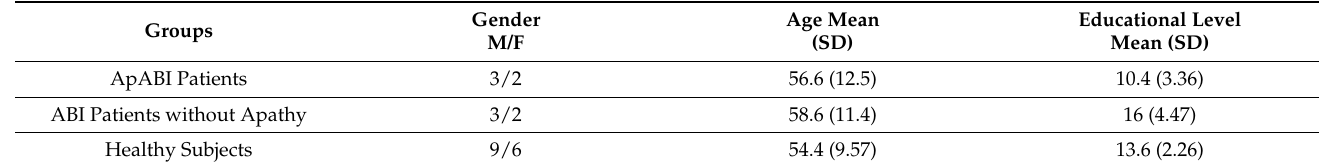
Table 3. Groups’ characteristics.